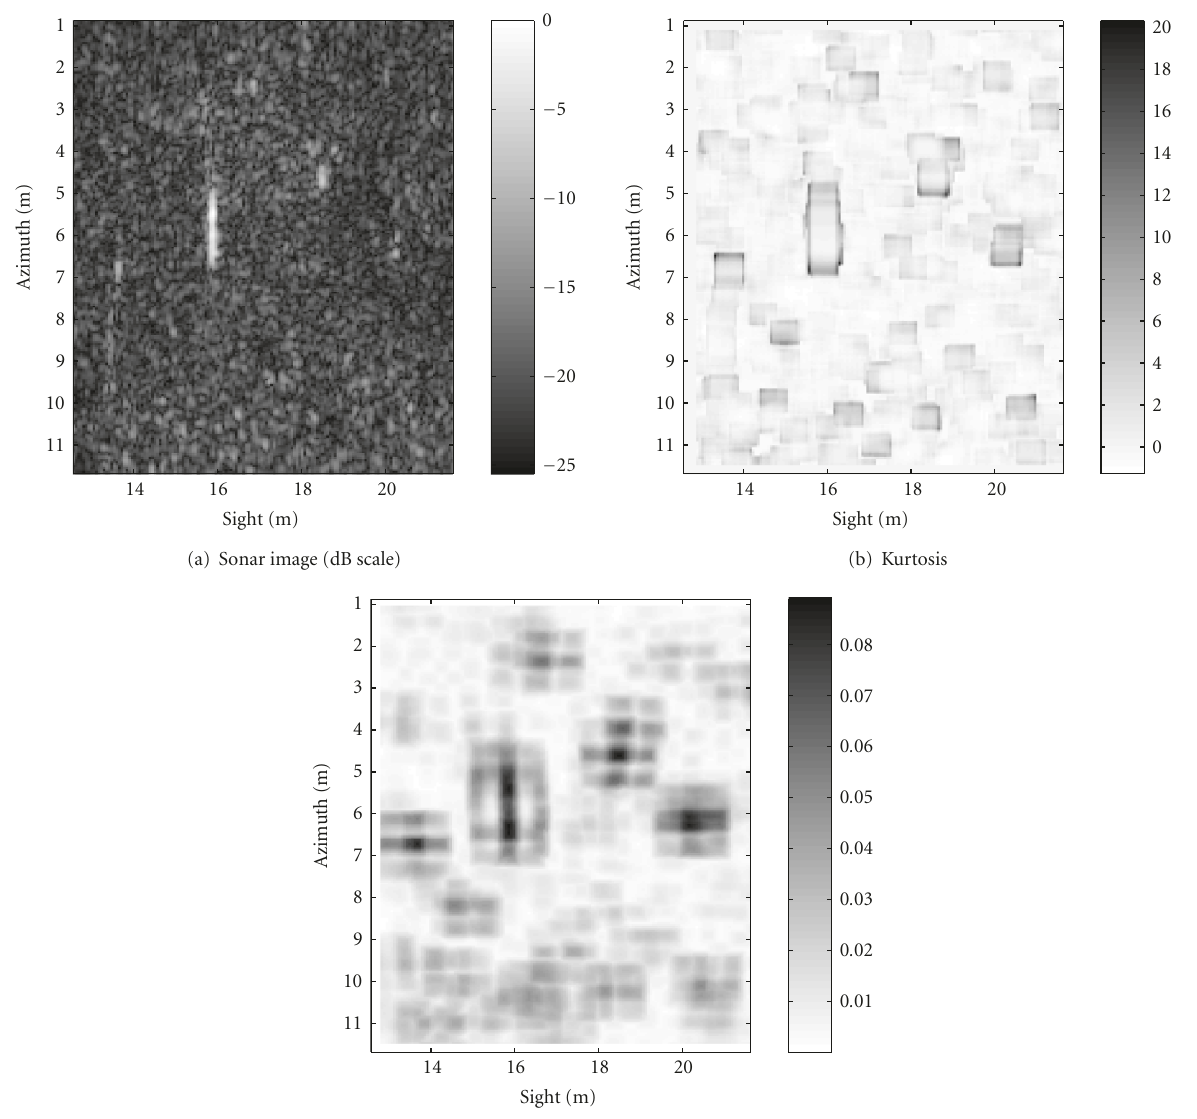
Figure 4: Estimation of kurtosis on the sonar image (Figure